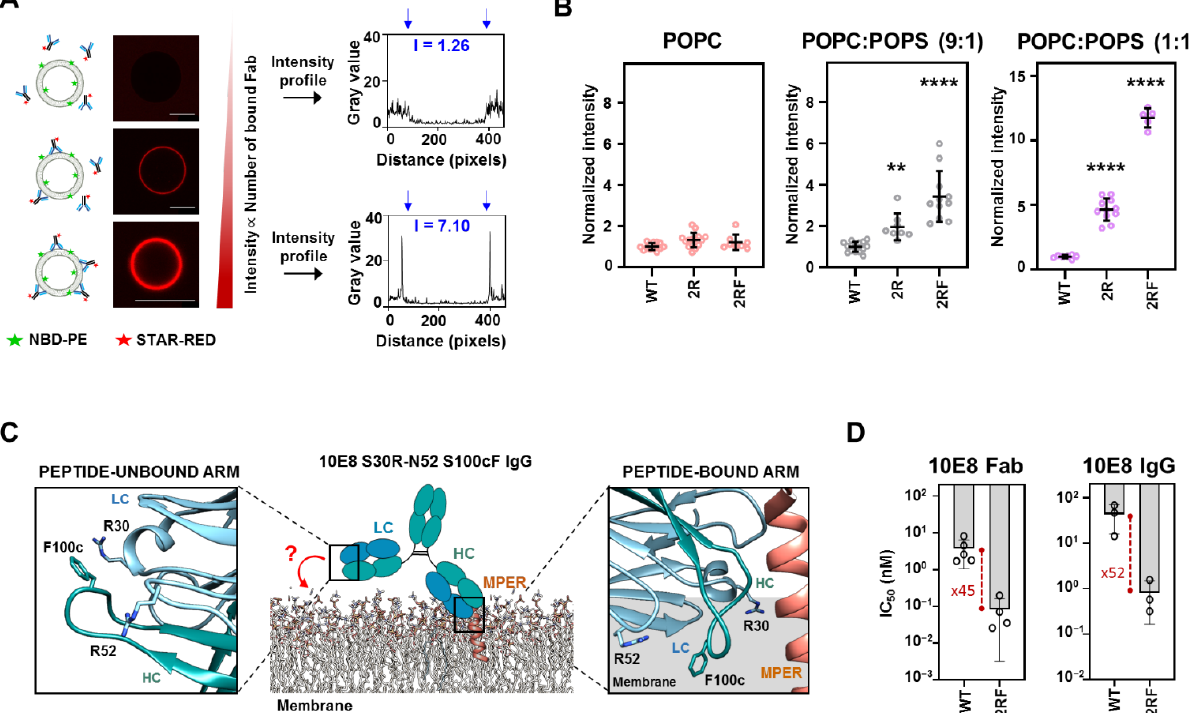
Figure 3. Contribution of the Arg-s and S100cF mutations in the direct binding of 10E8 to lipid membranes. ( A ) Scheme to illustrate Fab-binding quantification method to lipid vesicles. Fabs are labeled with the fluorescent dye STAR RED to lipid membranes. The lipid NBD-PE was used to localize the vesicles and the fluorescence intensity of STAR RED-Fabs at the lipid bilayer section (indicated with blue arrows) was recorded. Scale bars, 5 µ m. ( B ) Comparison of the binding intensities of 10E8 variants to vesicles (number of vesicles n ≥ 8) with increasing amount of the anionic phospholipid POPS (0% pink, 10% gray and 50% purple). ** and **** indicate significance compared to 10E8-WT ( p < 0.01 and p < 0.0001, respectively) by ANOVA. ( C ) Schematic cartoon to illustrate the possible avidity-based potency enhancement of IgG molecules through direct membrane binding. ( D ) IC 50 increase comparison against JRCSF PsV between mutated and 10E8-WT when displayed as monovalent Fabs or as bivalent IgG